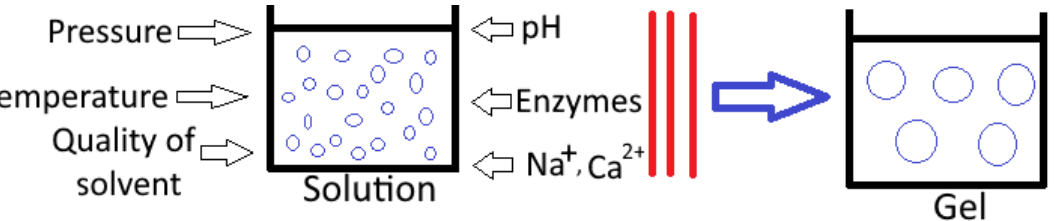
Figure 2. Different factors affecting the formation of food